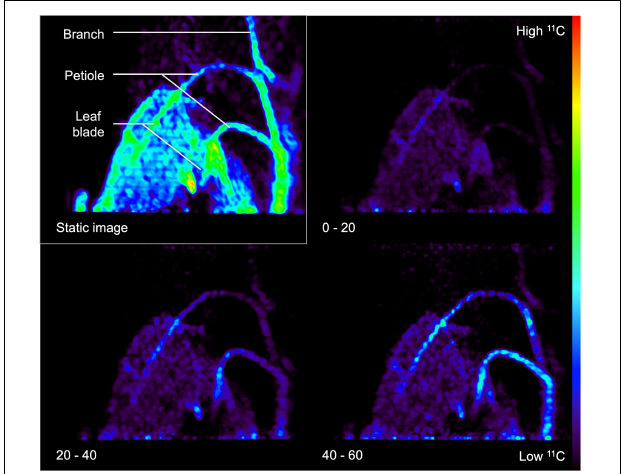
FIGURE 6 | Example of a static (upper left rectangle) and three dynamic PET images (timestamp in minutes shown in the lower left corner) of a Populus tremula branch that was exposed to gaseous 11 CO 2 during a 60-min PET acquisition. Transport of the label via the petioles to the branch is visualized by dynamic PET images. The static PET image (i.e., sum of dynamic images) has a better signal-to-noise ratio and can be used for drawing regions of interest (ROIs) around the branch or petiole. These ROIs can then be copied on the dynamic PET images to obtain tracer concentrations per ROI over time, i.e., time-activity curves